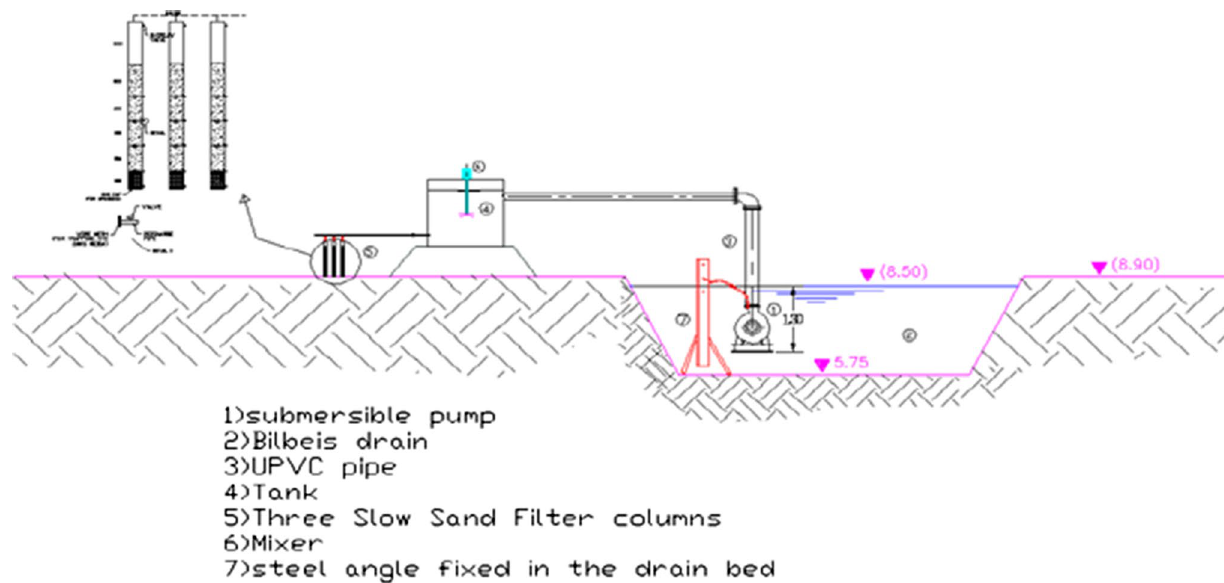
Fig. 3 A schematic diagram of the pilot